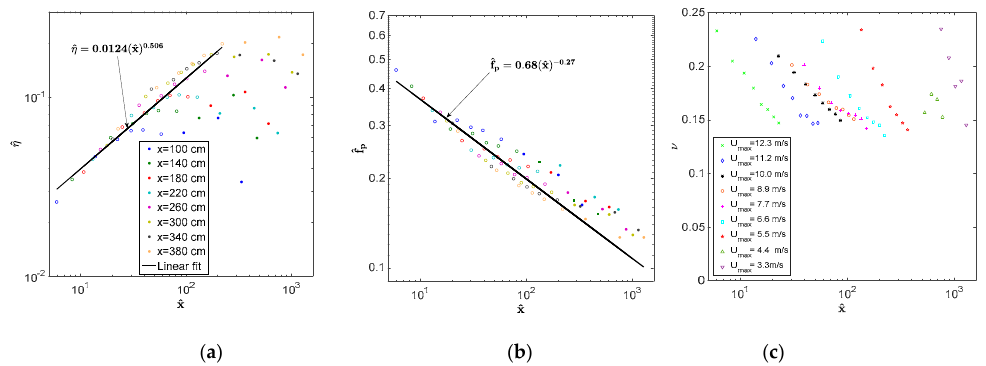
Figure 8. Dependence of various dimensionless statistical parameters on the dimensionless fetch ˆ x : ( a ) characteristic wave amplitude ˆ η ; ( b ) peak wave frequency ˆ f p , symbols as in ( a ); ( c ) spectral width υ .